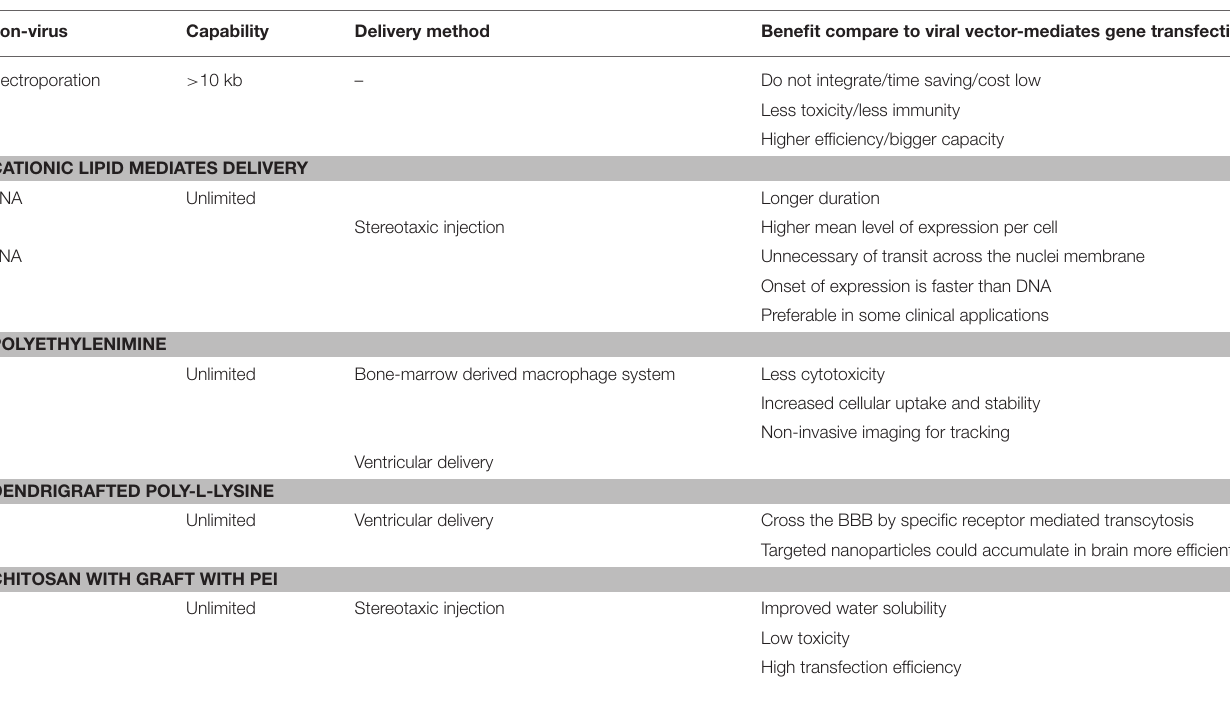
TABLE 1B | Alternative of viral vector-mediates gene